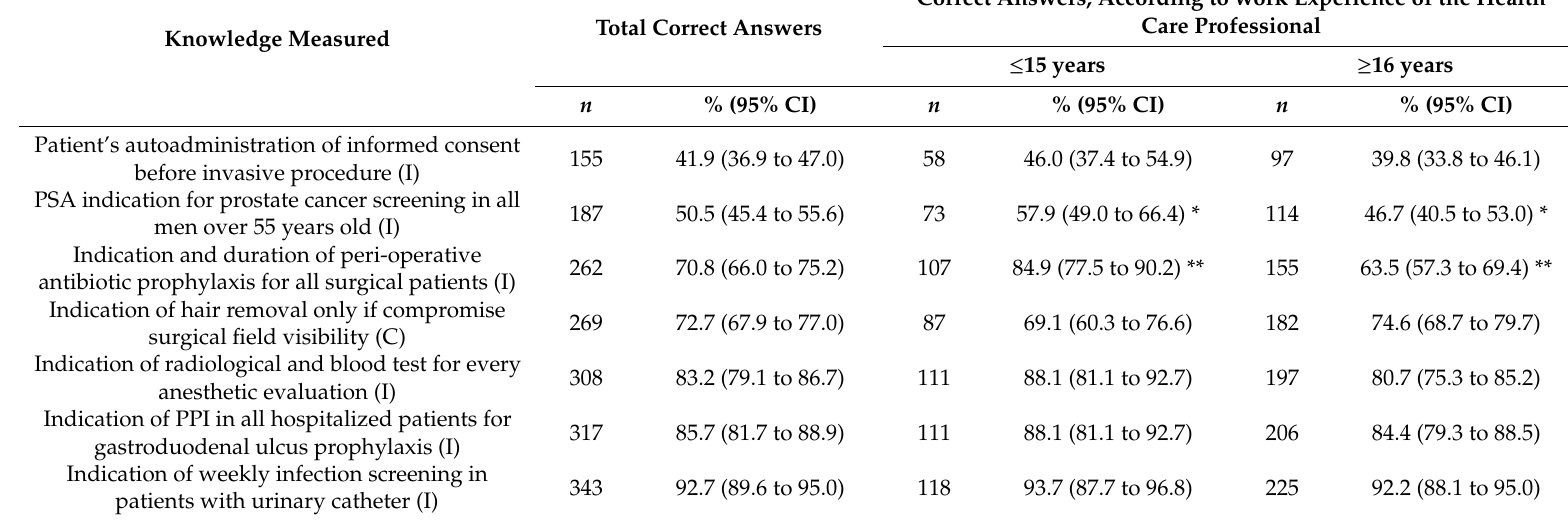
Table 2. Knowledge of some surgical related “Do not do” recommendations among surgical